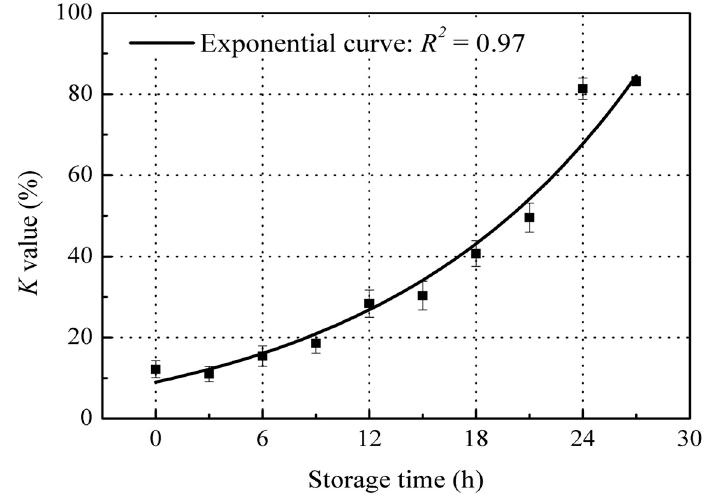
Figure 2. Changes in K value of red sea bream during storage at 22 ± 2 °C. Values shown are the means of three replicates with standard deviation bars.